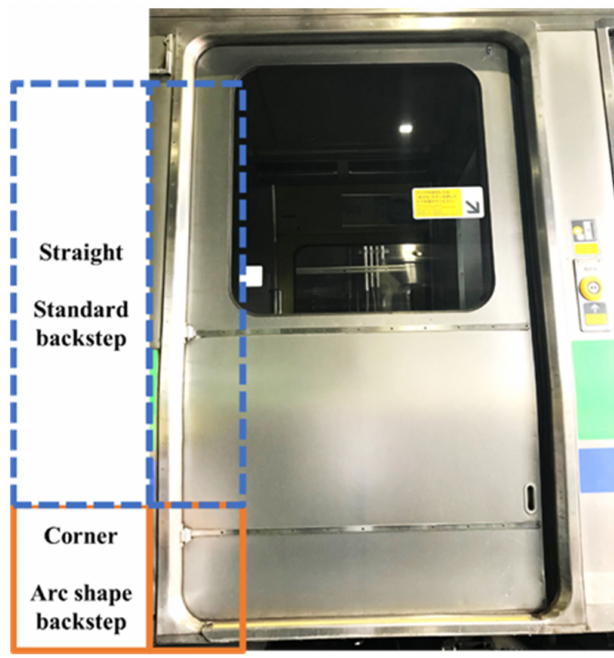
Figure 5. Modeling sites around the railcar